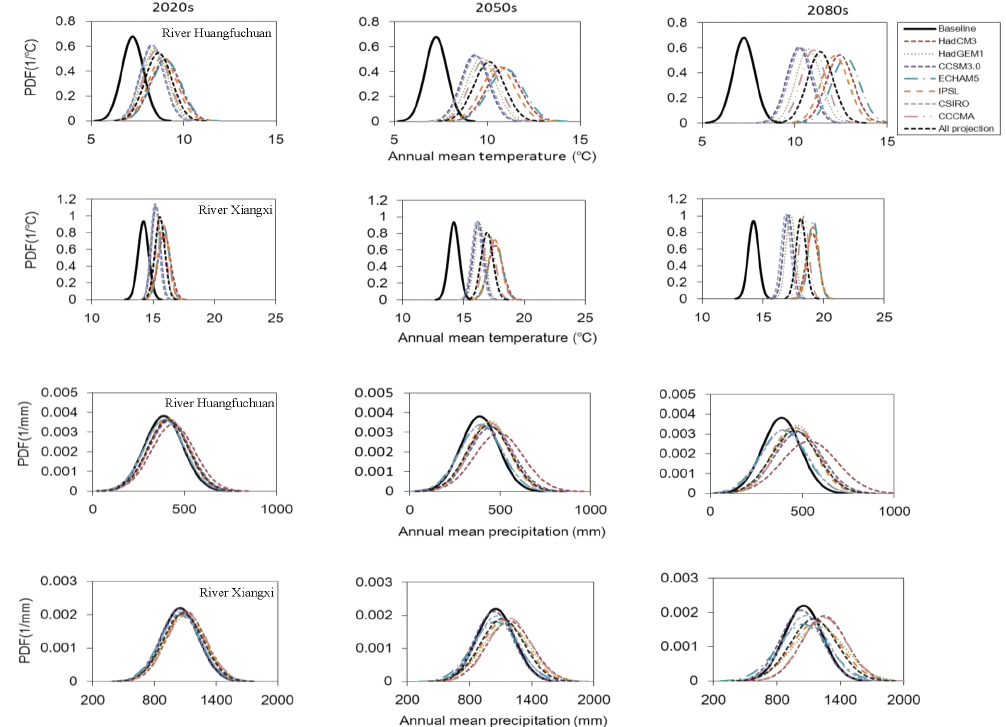
Figure 4. Probability density functions of annual mean temperature and annual precipitation for seven GCM projections for the 2020s, 2050s and 2080s time horizons and for the 1961–1990 baseline for the rivers Huangfuchuan and